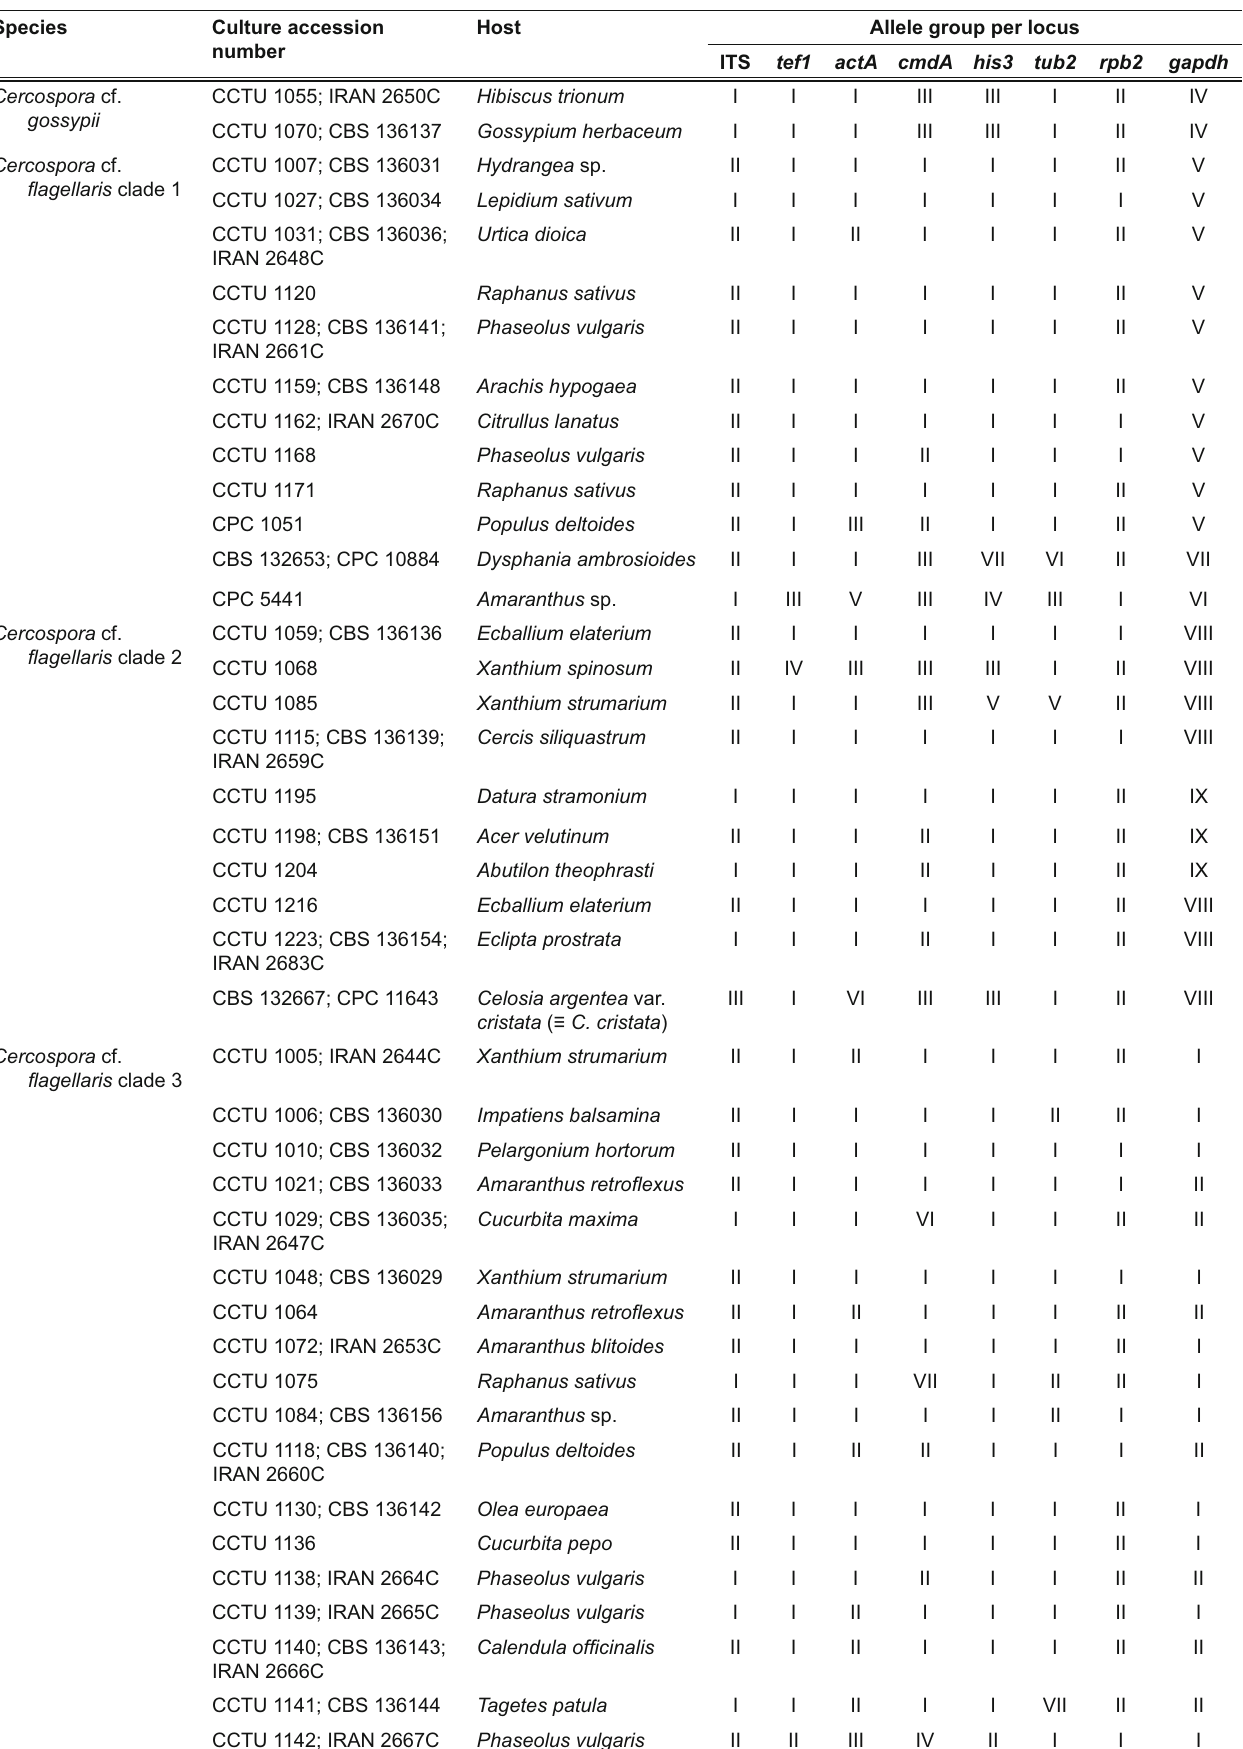
Table 8. G(cid:13)(cid:7)(cid:5)(cid:23)(cid:8)(cid:7)(cid:2)(cid:26)(cid:10)(cid:4)(cid:6)(cid:2)(cid:9)(cid:23)(cid:23)(cid:13)(cid:23)(cid:13)(cid:2)(cid:25)(cid:10)(cid:4)(cid:5)(cid:18)(cid:2)(cid:21)(cid:13)(cid:7)(cid:11)(cid:25)(cid:17)(cid:9)(cid:8)(cid:11)(cid:4)(cid:17)(cid:2)(cid:18)(cid:13)(cid:10)(cid:2)(cid:23)(cid:4)(cid:19)(cid:5)(cid:7)(cid:2)(cid:26)(cid:4)(cid:10)(cid:2) Cercospora (cid:2)(cid:19)(cid:26)(cid:28)(cid:2) (cid:2)(cid:3)(cid:4)(cid:5)(cid:6)(cid:6)(cid:3)(cid:7)(cid:8)(cid:9) (cid:2)(cid:11)(cid:7)(cid:4)(cid:23)(cid:9)(cid:8)(cid:13)(cid:7)(cid:2)(cid:11)(cid:17)(cid:2)(cid:8)(cid:14)(cid:11)(cid:7)(cid:2)(cid:7)(cid:8)(cid:5)(cid:21)(cid:22)(cid:28)(cid:2)/(cid:12)(cid:12)(cid:10)(cid:13);(cid:11)(cid:9)(cid:8)(cid:11)(cid:4)(cid:17)(cid:7)(cid:2)(cid:4)(cid:26)(cid:2)(cid:23)(cid:4)(cid:19)(cid:11)(cid:2)(cid:9)(cid:17)(cid:21)(cid:2)(cid:19)(cid:4)(cid:23)(cid:23)(cid:13)(cid:19)(cid:8)(cid:11)(cid:4)(cid:17)(cid:2) (cid:9)(cid:19)(cid:19)(cid:13)(cid:7)(cid:7)(cid:11)(cid:4)(cid:17)(cid:2)(cid:17)(cid:5)(cid:6)(cid:12)(cid:13)(cid:10)(cid:7)(cid:2)(cid:26)(cid:4)(cid:23)(cid:23)(cid:4)(cid:15)(cid:2)<(cid:9)(cid:12)(cid:23)(cid:13)(cid:2)!(cid:28) Species Culture accession Host Allele group per locus number ITS tef1 actA cmdA his3 tub2 rpb2